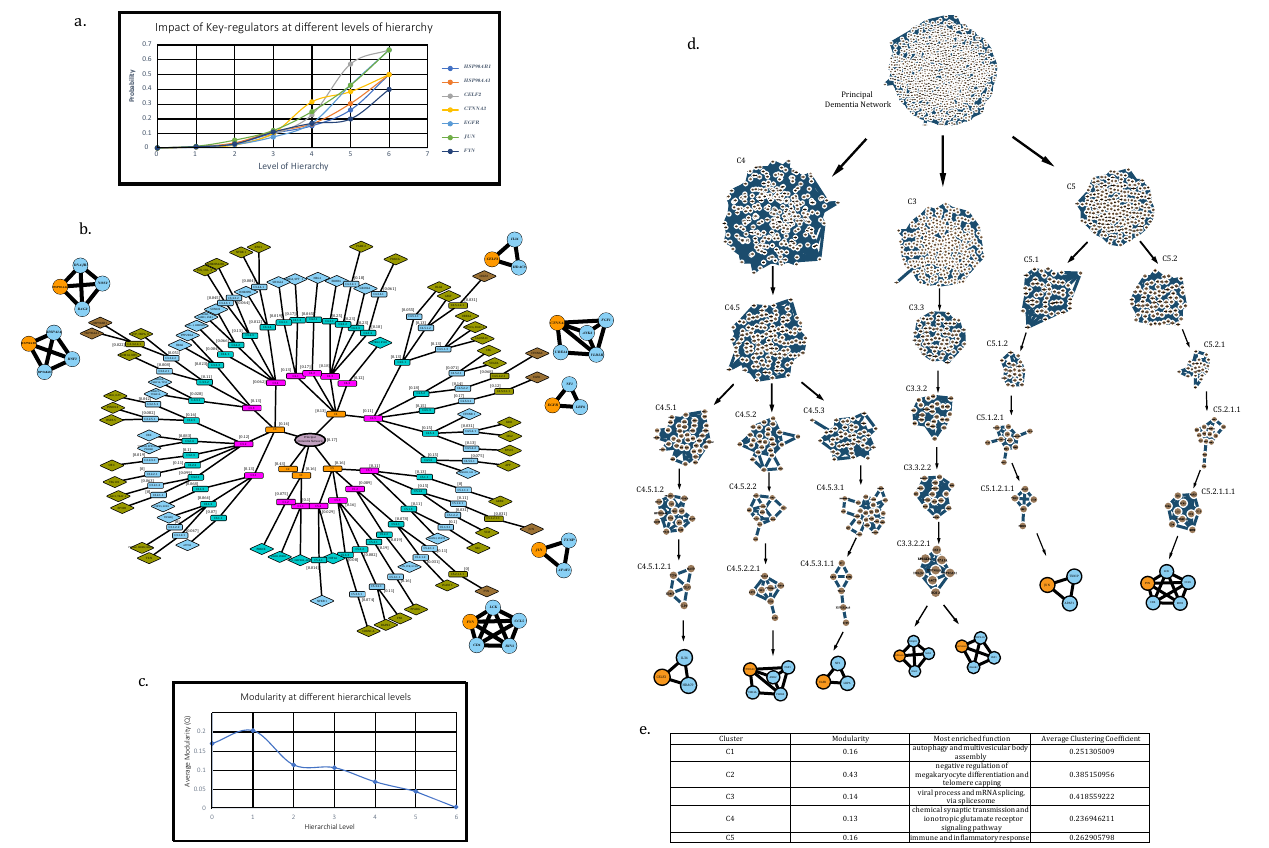
Figure 4. Community detection using the Louvain method of modularity (Q) maximization. ( a ) Prob- ability graph to show the increasing impact of key regulators as we move deeper into the network’s hierarchy. ( b ) Representation of all communities obtained through the aforementioned algorithm while tracing the high-degree hubs from level 0 (principal dementia network) up to motifs at different hierarchical levels in order to find key regulators (HSP90AA1, HSP90AB1, CELF2, FYN, JUN, EGFR). Modularity values for each community have been mentioned in square bracket except for motifs (motifs have 0 modularity). ( c ) Graph showing the fall in value of modularity as we move deeper into network’s hierarchy. ( d ) Illustration of communities containing KRs at every hierarchical level in the network. ( e ) Functions and modularity of clusters at first hierarchical